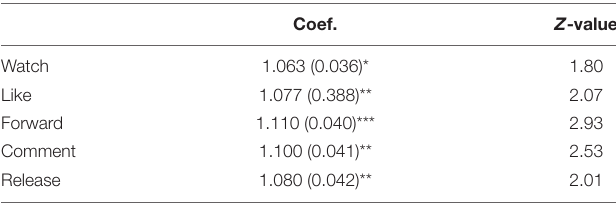
TABLE 4 | The impact of social media participation on farmers’ adoption intensity of LAPs.